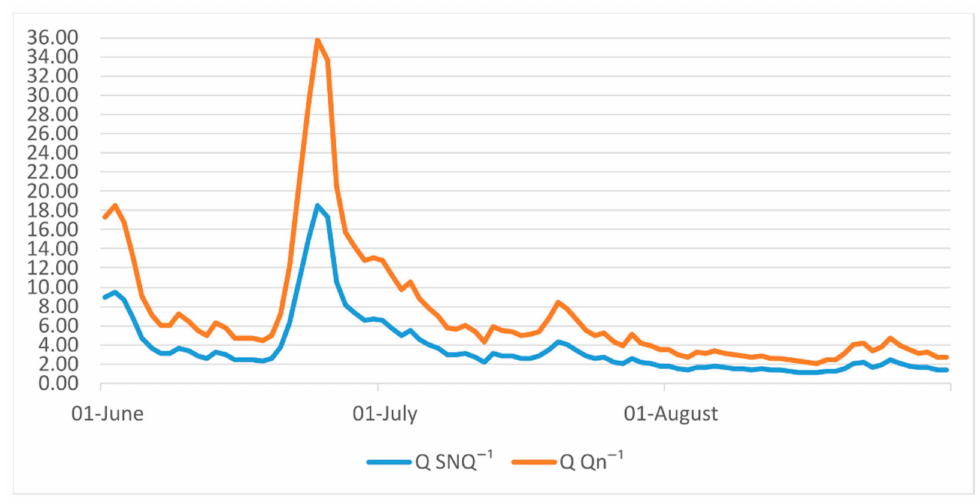
Figure 17. Relative water flow in the Wisła River (Szczucin) concerning the SNQ and Q n index. The water level in the Wisla River from 1 June to 31 August ranged from 92 to 575 cm (Szczucin water gauge station) (Figure 18). There is a clear correlation between the flow values and the water level. As in the case of the average flow, the highest water levels were recorded in June (when the warning level was exceeded), while the lowest values took place in August.